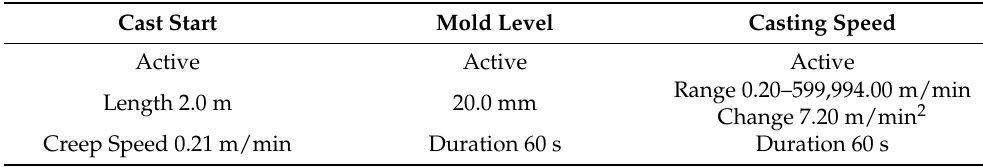
Table 4. Breakout precondition.